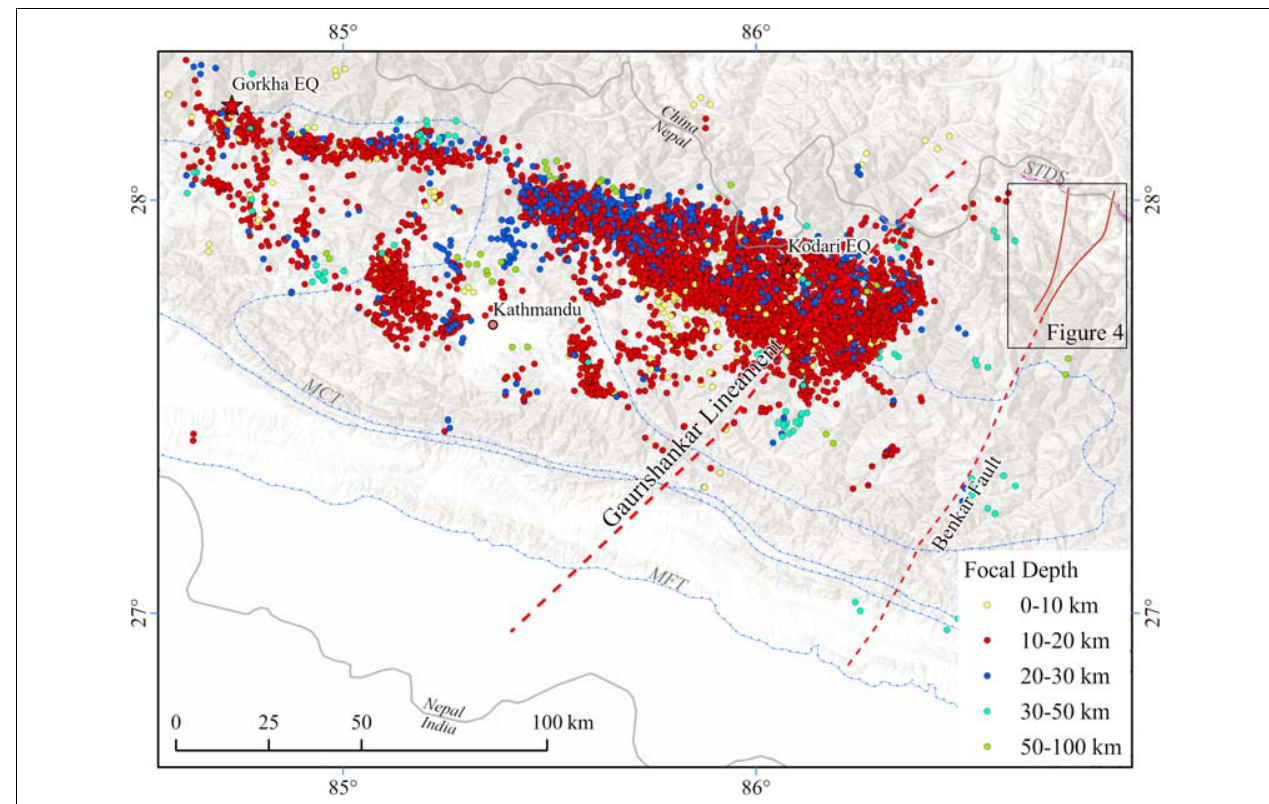
FIGURE 5 | Map of aftershock locations from the 2015 Nepal earthquakes. Epicenters of the two major earthquakes are shown with stars. Colored dots represent the locations of aftershocks. The solid red lines denote the bounds of the mapped portion of the Benkar Fault (Seifert, 2019) and the dotted red lines are the projected traces from satellite imagery of the Benkar Fault and the Gaurishankar lineament (Dasgupta et al., 1987). Note the abrupt termination of the zone of aftershocks on the east side that is sub-parallel to both the Gaurishankar lineament and the Benkar Fault. MBT: Main Boundary Thrust; MCT: Main Central Thrust; MFT: Main Frontal Thrust; STDS: South Tibetan Detachment System (Figure by Bibek Giri with data from Abhijit Ghosh and Mendoza et al., 2019).